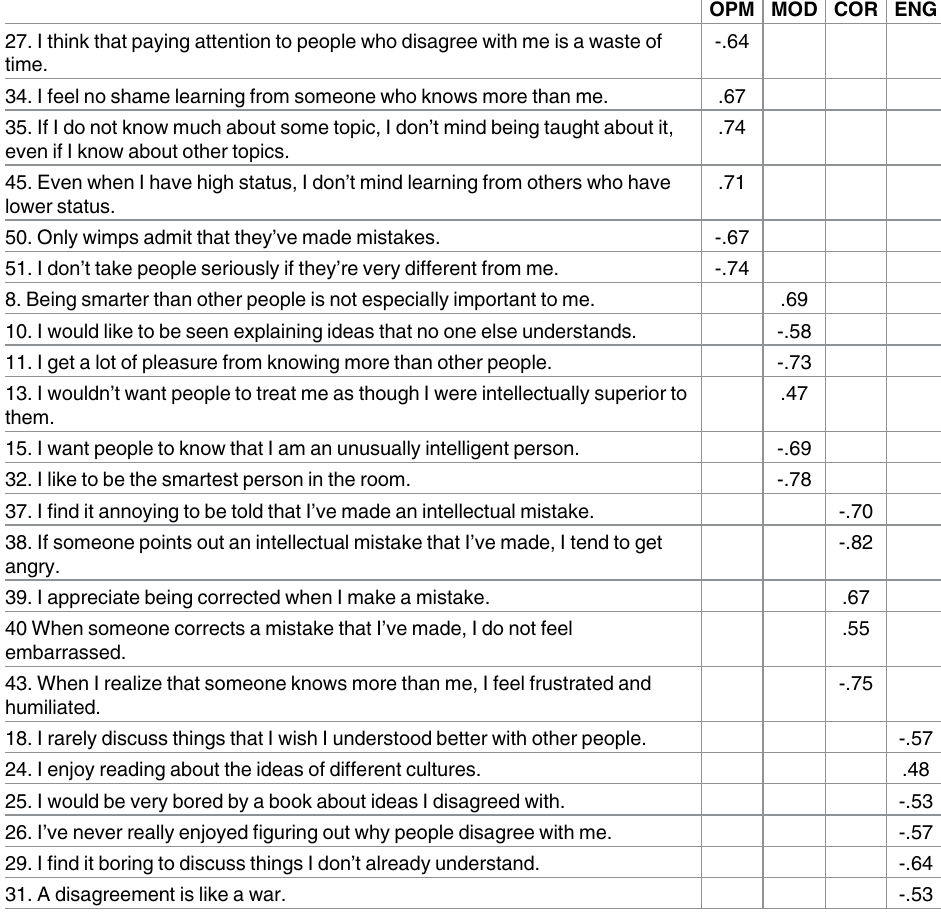
Table 2. The final 4-Factor solution from Study 2 after